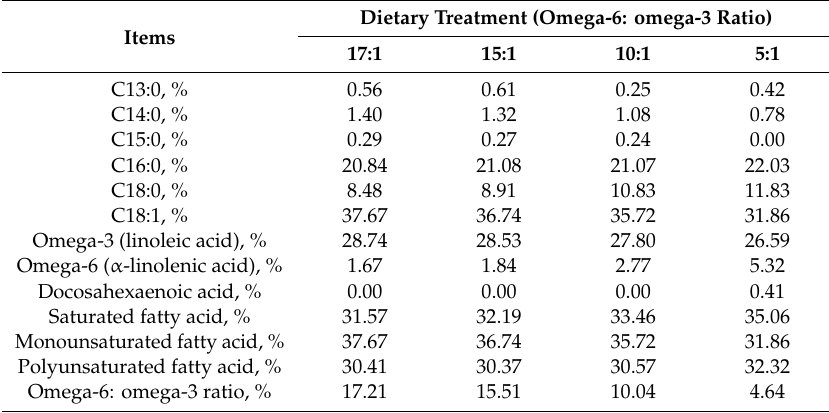
Table 2. Analyzed fatty acid profile of the experimental